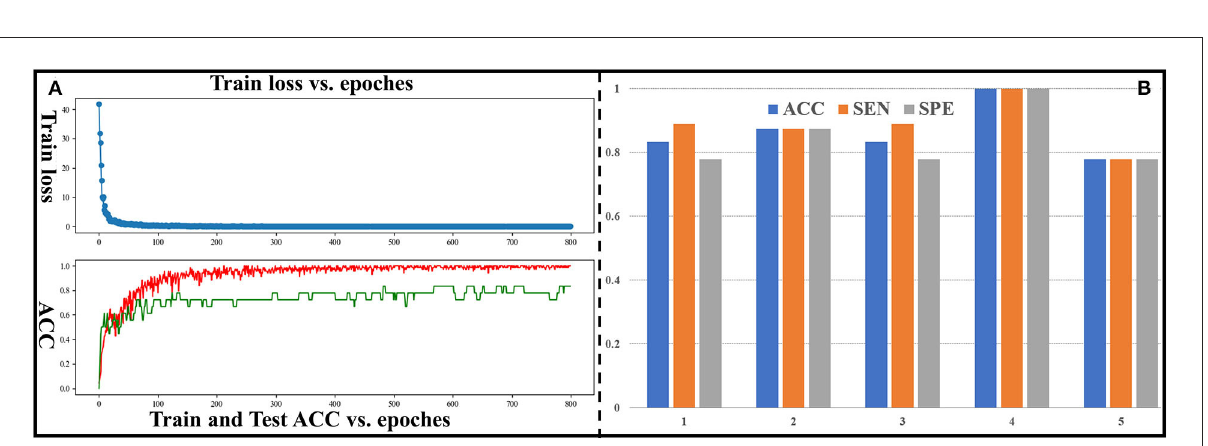
FIGURE3 (A) Curve of train loss and ACC for the fourth group. The red curve represents ACC of the training set, and the green curve represents ACC of the test set. (B) ACC, SEN, and SPE for all groups.